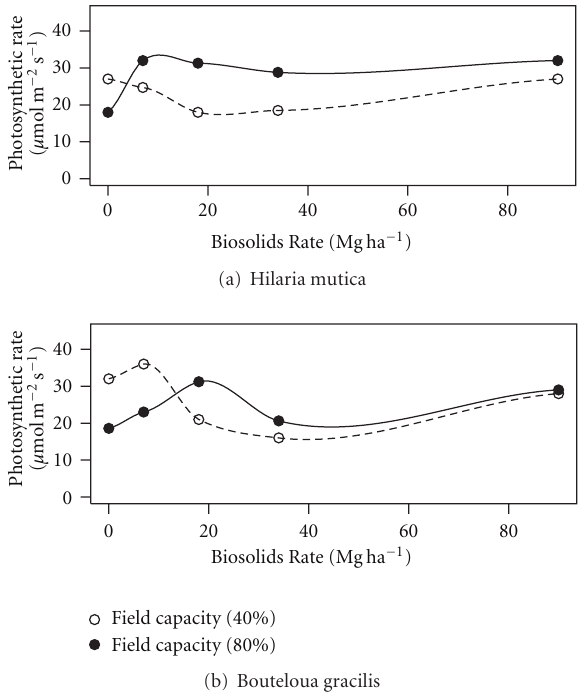
Figure 6: Photosynthetic rate ( µ molm − 2 s − 1 ) of Bouteloua gracilis and Hilaria mutica as a ff ected by biosolids application in soil maintained at 40% or 80% field capacity (redrawn from